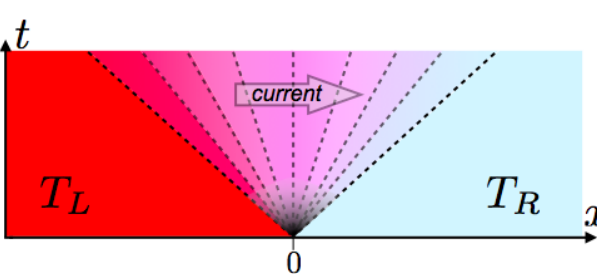
Figure 13: A continuum of states, parametrised by the ray ξ = x / t , emerges in the partitioning protocol for integrable systems, where ballistic currents exist.